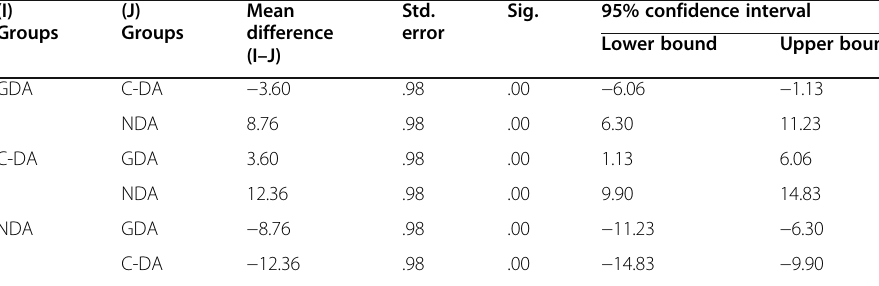
Table 11 Results of the Scheffe post hoc test for comparing GDA, C-DA, and N-DA mean scores on the speaking fluency